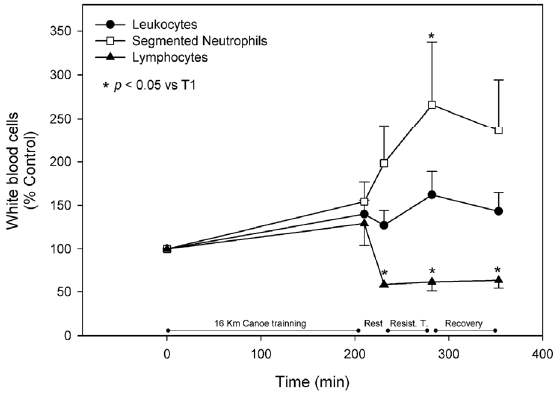
Figure 4. White blood cells. Leukocytes, segmented neuthrophils, and lymphocytes were measured as described in materials and methods and are represented as mean ± standard error of percentage values against control. * Indicates statistical difference against control values ( p < 0.05).